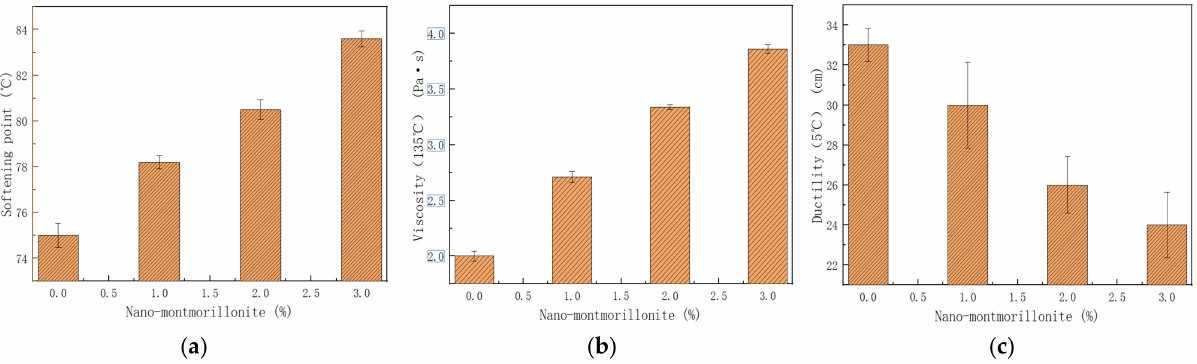
Figure 2. Effects of nano-montmorillonite on the ( a ) softening point and ( b ) viscosity and ( c ) ductility of SBS-modified